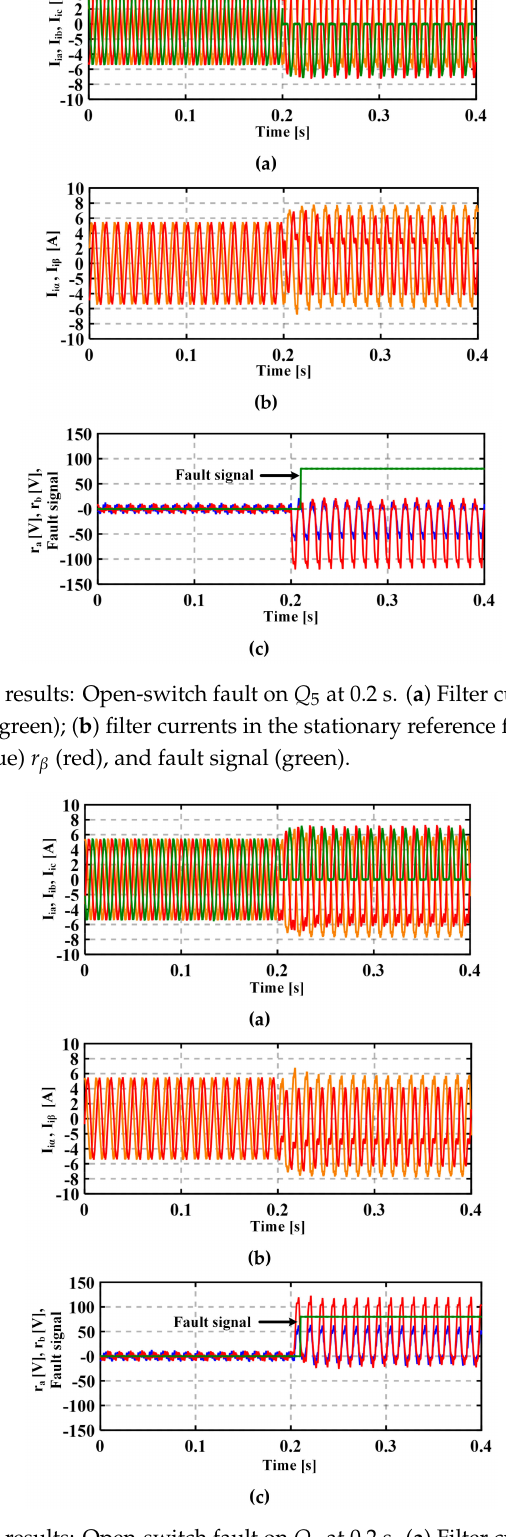
Figure 13. Experimental results: Open-switch fault on Q 6 at 0.2 s. ( a ) Filter currents of the three phases I ia (yellow), I ib (red), I ic (green); ( b ) filter currents in the stationary reference frame i i α (yellow), i i β (red); ( c ) r α (blue) r β (red), and fault signal